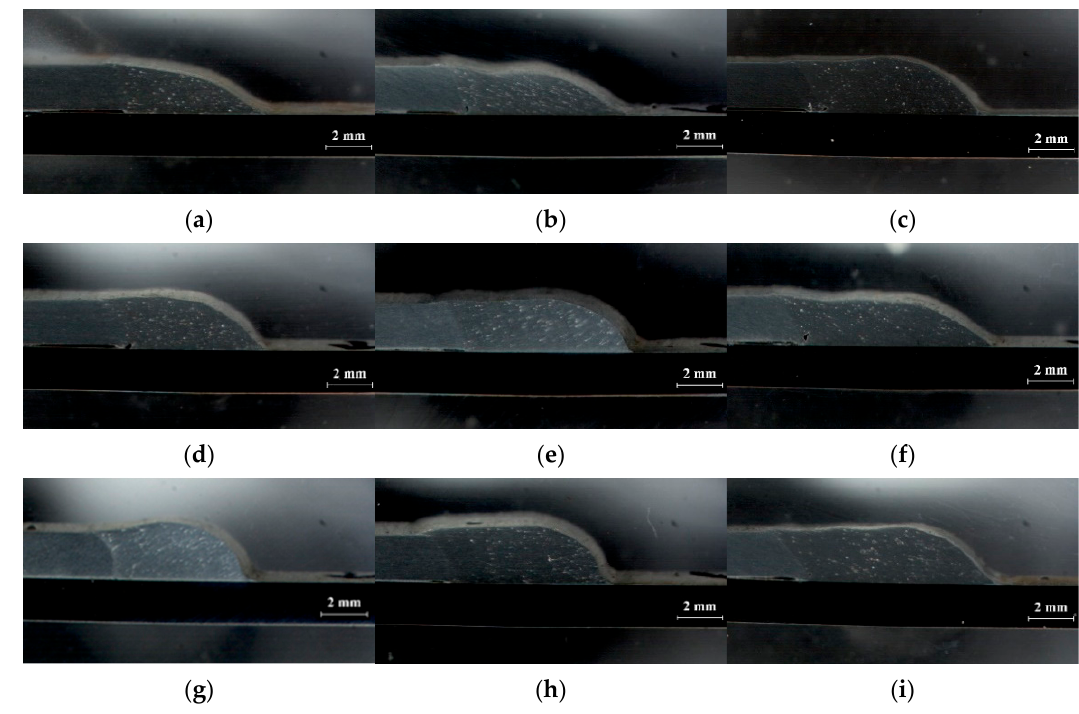
Figure 2. Cross-section of welded joints with EN ratio for various currents: ( a ) 50 A, 0%; ( b ) 60 A, 0%; ( c ) 70 A, 0%; ( d ) 50 A, 10%; ( e ) 60 A, 10%; ( f ) 70 A, 10%; ( g ) 50 A, 20%; ( h ) 60 A, 20%; ( i ) 70 A, 20%.